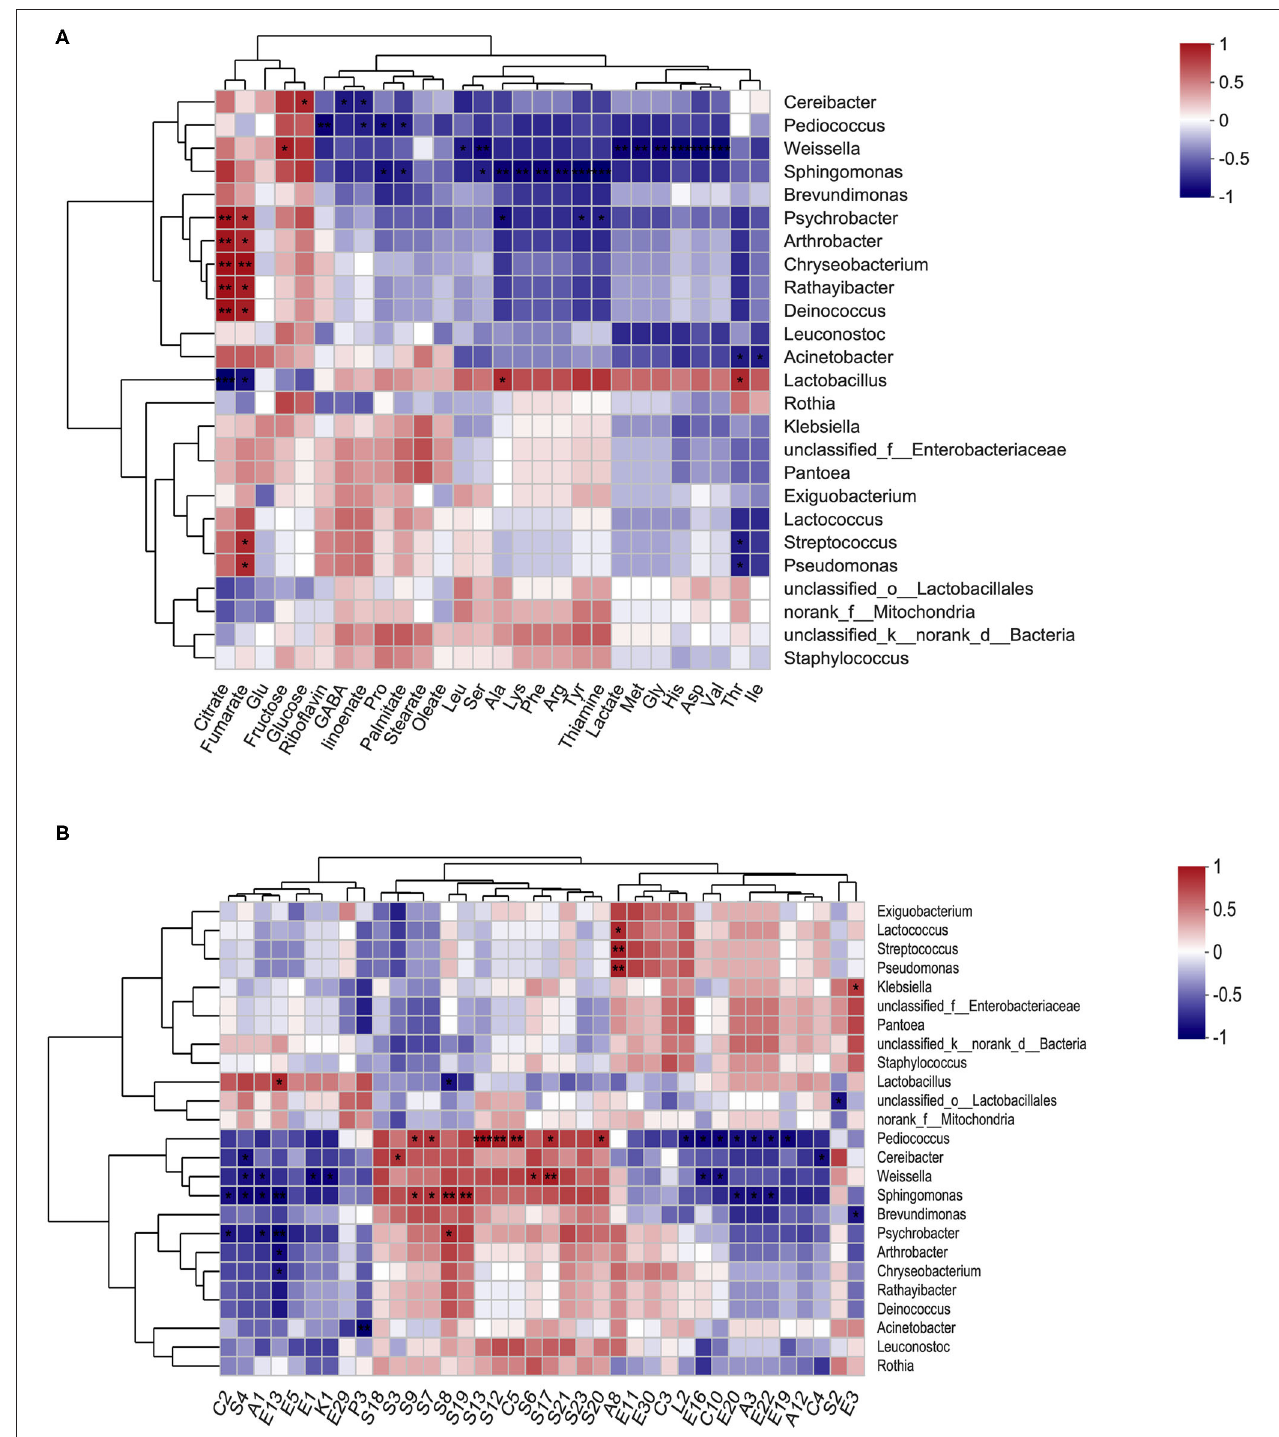
FIGURE 6 | Correlation between microbial structure and metabolite indices. A heatmap of Spearman’s correlation between the prominent genera (top 25) and nutrients (A) , and the prominent genera (top 25) and volatiles (with relative abundance > 0.5%) (B) . The color intensity represents the degree of association (red, positive correlation; blue, negative correlation), and significant correlations are marked by * p < 0.05, ** p < 0.01, and *** p < 0.001.